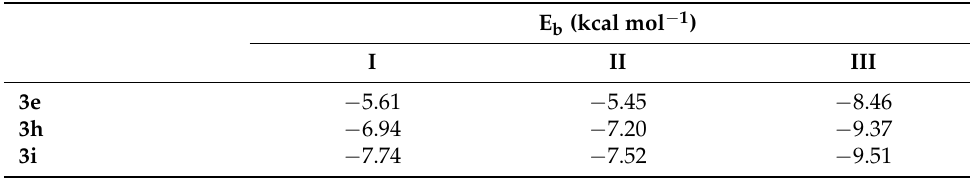
Table 3. Energies of binding (E b ) derived from docking of 3e , 3h , and 3i to DNA (I), Escherichia coli Gyrase B (II), and topoisomerase II beta